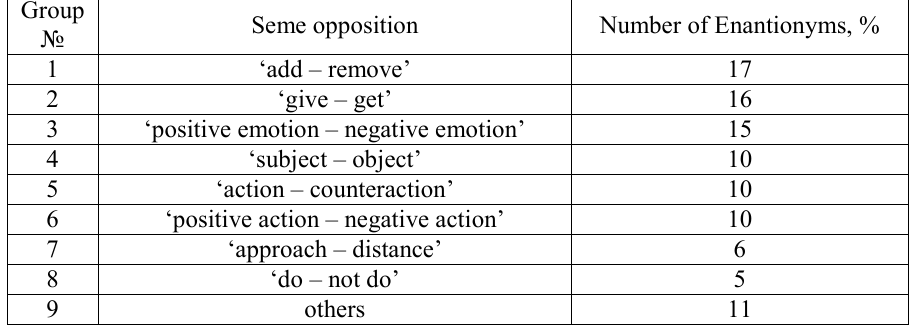
Table 1 – Groups of verbal enantionyms according to the seme opposition within their semantic structure